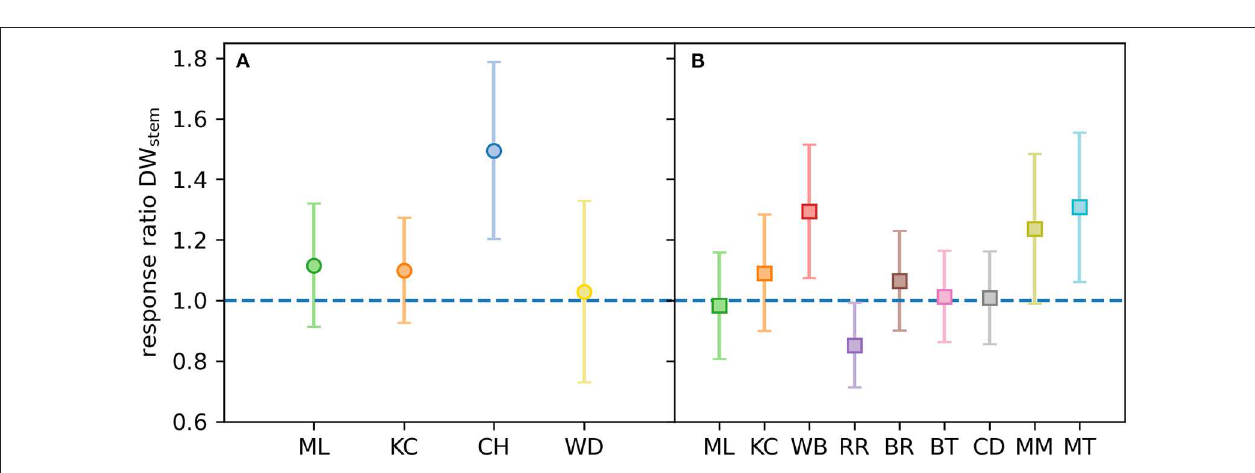
Frontiers in Forests and Global Change |